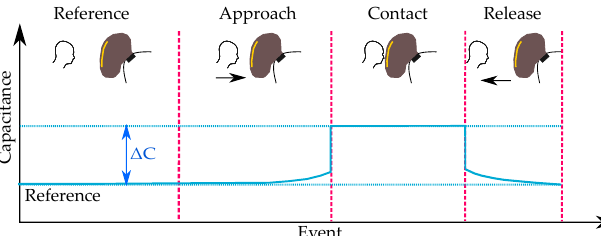
Figure 3. Capacitance variation as a function of occupant’s distance from the airbag. Equation (1) gives the voltage across the sensor [19,20,24,25]. The voltages across the capacitor and the supply are V cap and V s , respectively. t is the time elapsed after the supply and R is the resistor’s resistance. The permittivities of vacuum and dielectric material are ε 0 and ε r , respectively. A denotes the plate area (contact surface area between the occupant and the sensor), and d is the separation distance (Figure 2).